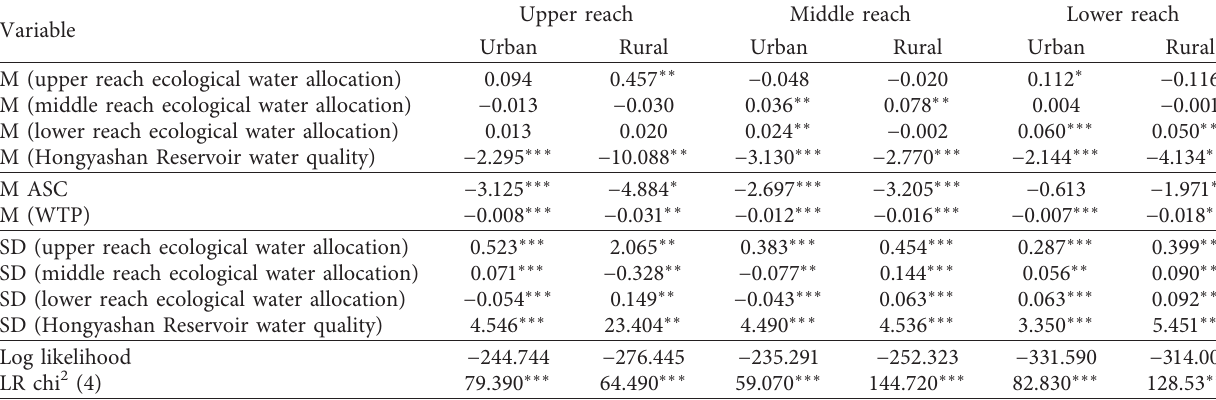
Table 4: Results of RPL model